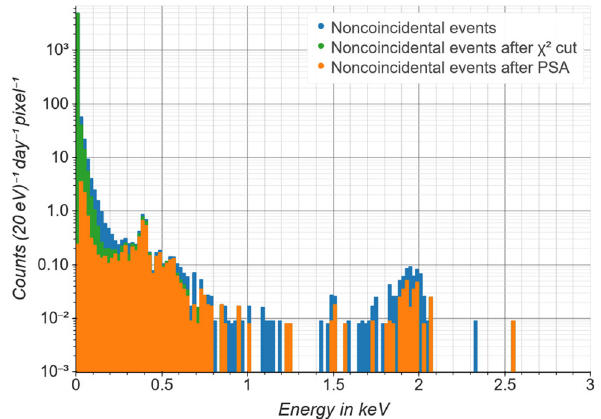
Fig. 14 Energy distribution of non-coincidental events measured by the background pixels. The blue spectrum shows all measured events. The orange spectrum shows the actual background spectrum